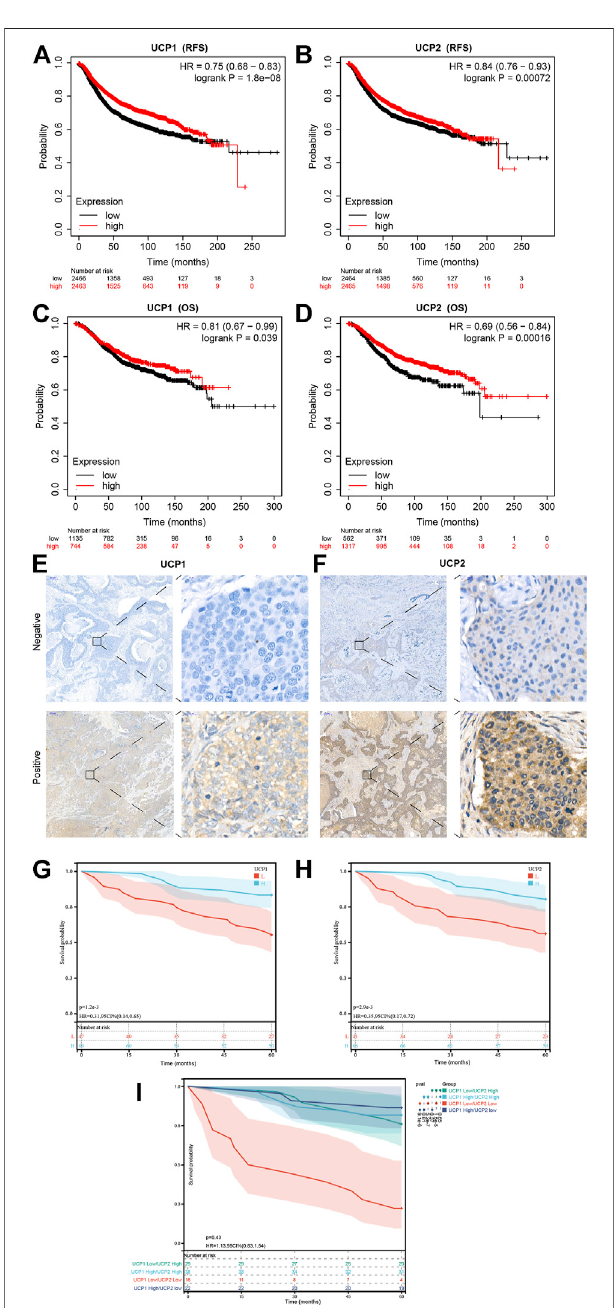
FIGURE2| PrognosticvalueofUCP1and UCP2inbreastcancer. (A,B) RFS curves for (A) UCP1 and (B) UCP2 in breast cancer using the Kaplan- Meier plotter. (C,D) OS curves of (C) UCP1 and (D) UCP2 in breast cancer using the Kaplan-Meier plotter. (E,F) Representative immuno fl uorescence staining images for (E) UCP1 and (F) UCP2. (G,H) RFS curves for (G) UCP1 and (H) UCP2 in cohort 2.